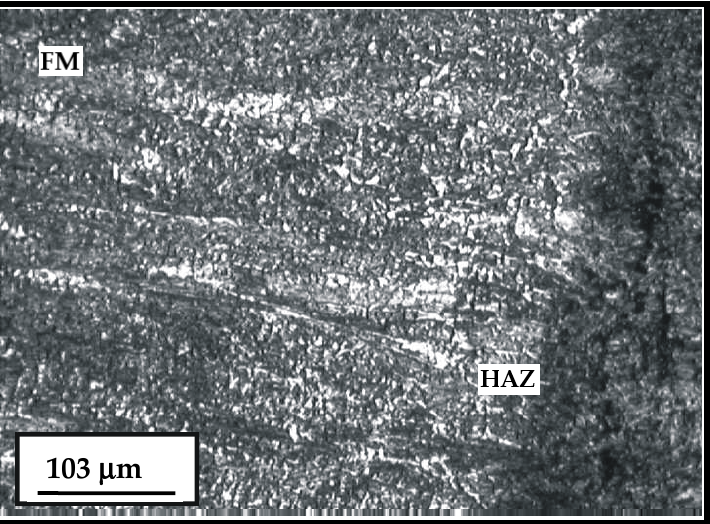
Figure 10. Microstructure of the hard-faced layer executed by FM UTP 670 (light areas) and HAZ (dark area).